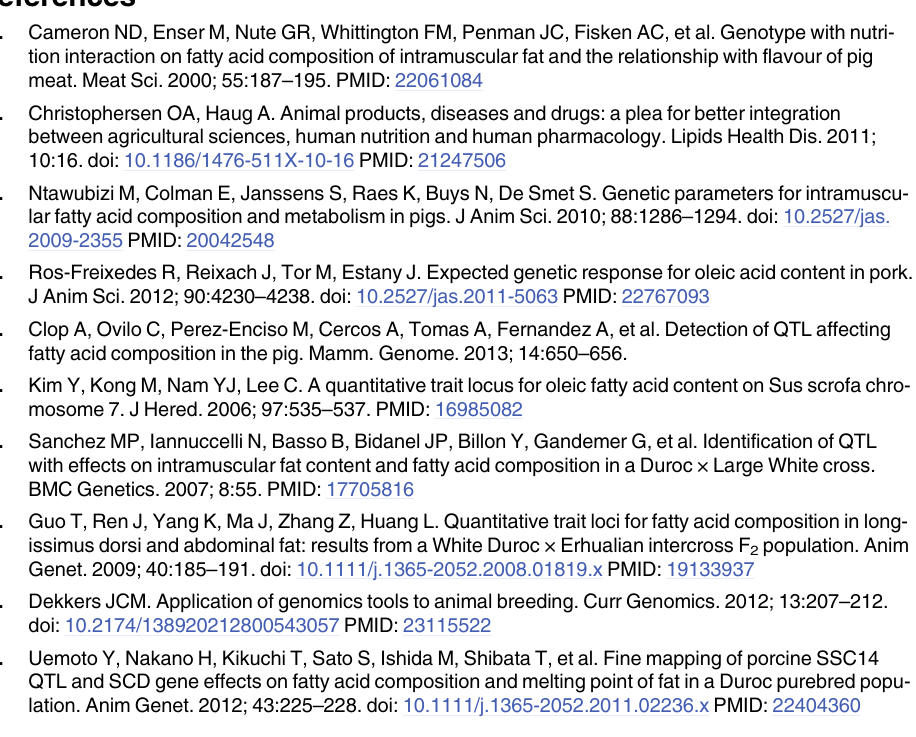
S1 Table. Primers used for genotyping the single nucleotide polymorphisms (SNP) in the porcine SCD gene promoter (AY487830: g . 2228T > C ) and exon 14 of LEPR